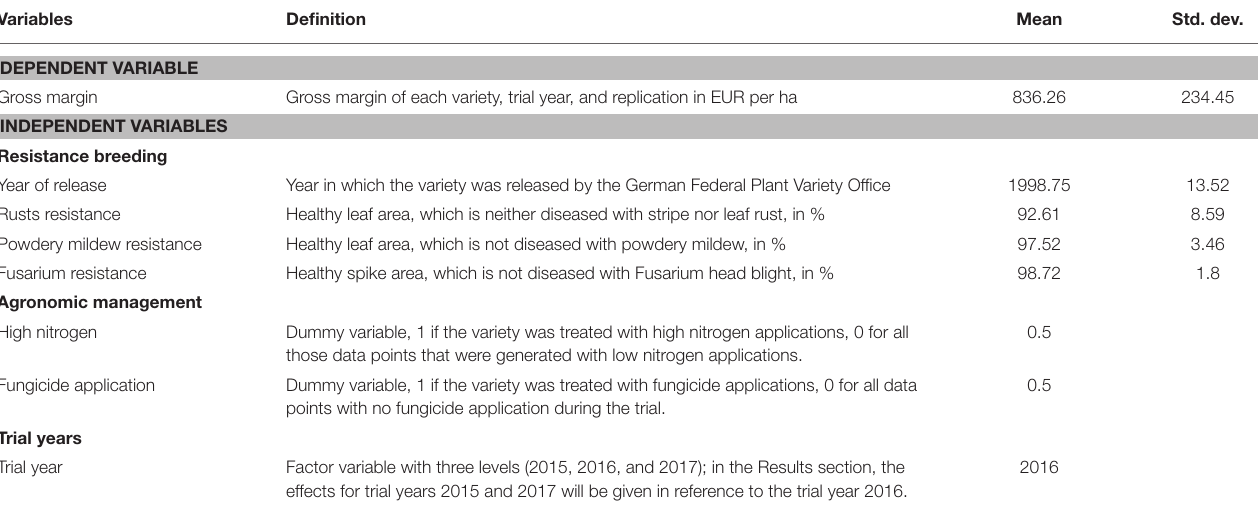
TABLE 2 | Variables within the regression